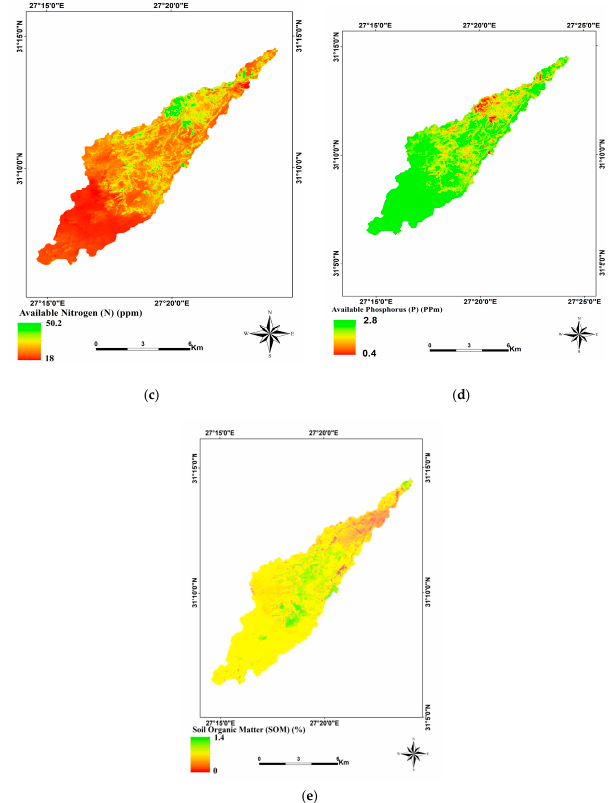
Figure 5. Spatial distribution of predicted soil properties using OLI satellite images: ( a ) nitrogen (N); ( b ) phosphorus (P); ( c ) potassium (K); ( d ) pH; and ( e ) SOM.